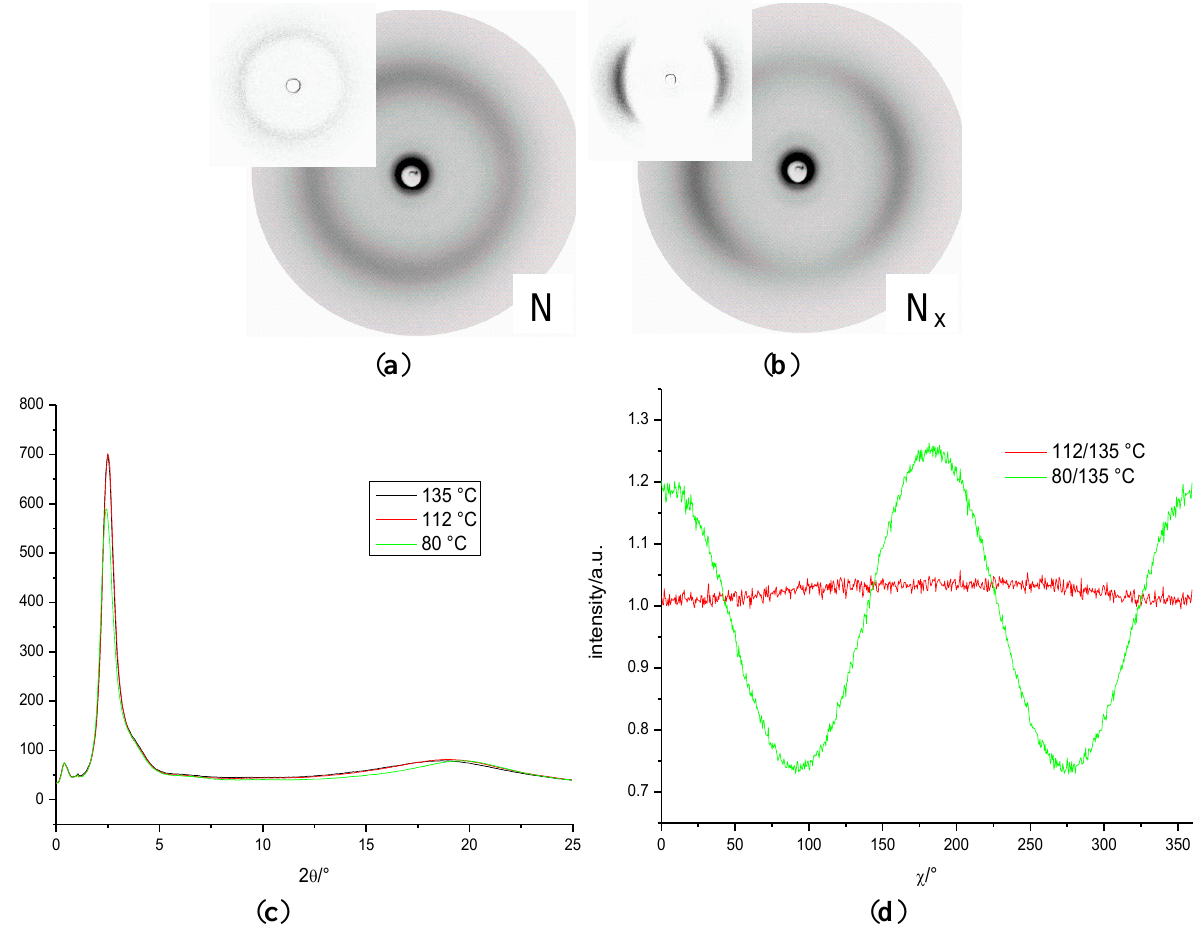
field upon cooling: ( a ) N phase at 112 °C (the insert subtracted intensities were recorded in the isotropic phase); ( b ) N at 80 °C (the insert subtracted intensities of the isotropic x phase); ( c ) θ-scan of the diffraction pattern in the N and N phases; SAXS: d = 0.470 nm x (112 °C), d = 0.453 nm (80 °C); ( d ) distribution of the wide-angle scattering along χ in the N and N phases; intensity vs . χ (15°–25° x